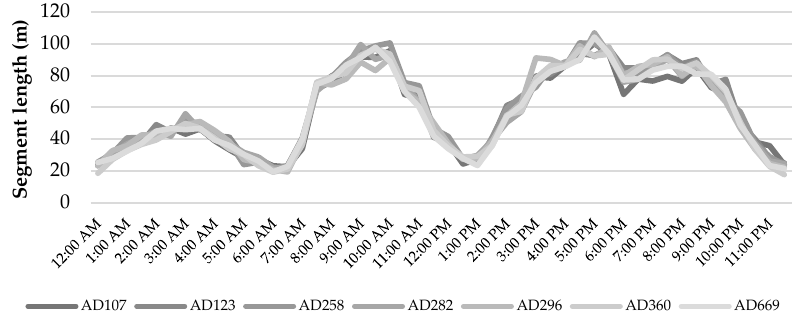
Figure 5. Individual variability of the daily activities of cattle. Daily activity patterns were not constant during the experimental period. Significant differences in the average length of trajectory segments at various timestamps were ob-